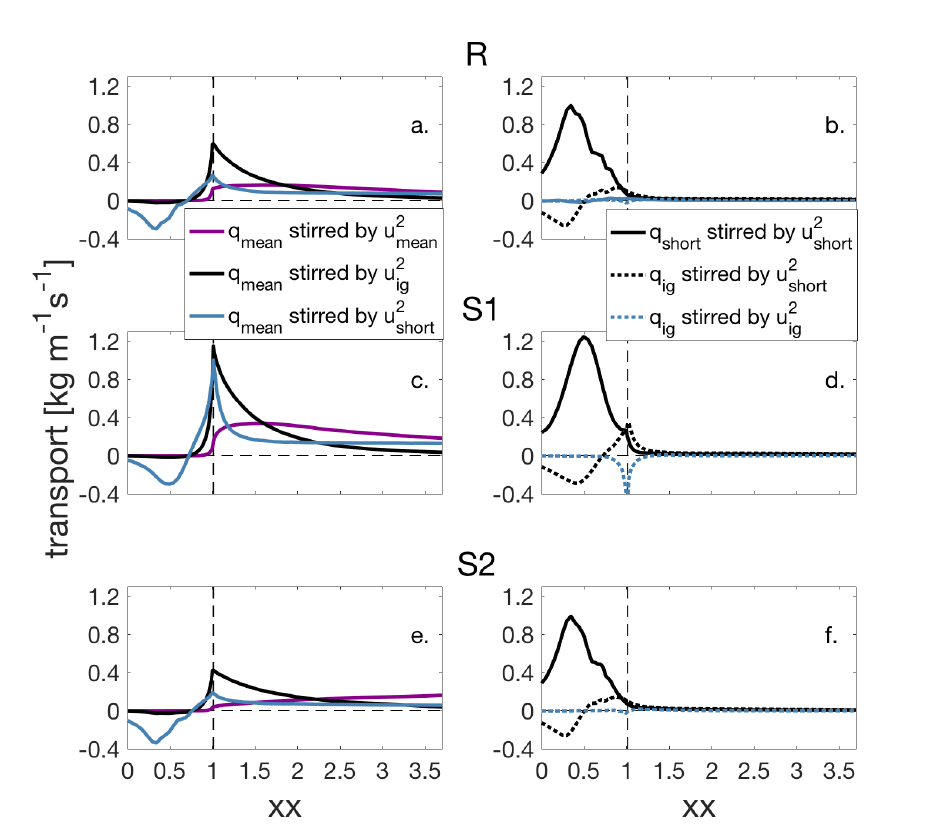
Figure 7. Stirring processes for q mean ( a , c , e ), q short ( b , d , f ) and q ig ( b , d , f ) for R ( a , b ), S 1 ( c , d ) and S 2 ( e , f ) on a normalized grid ( xx ) from the beginning of the seaward slopes ( xx = 0) to the back barrier basin ( xx = 3.7). Grid locations before the crest (indicated by the vertical dashed line) indicate output in the same water depth (but not the same distance in reference to the crest), while they are equidistant and at the same depth after the crest for R and S 1 (but not for S 2 for which the island top has the same height as the